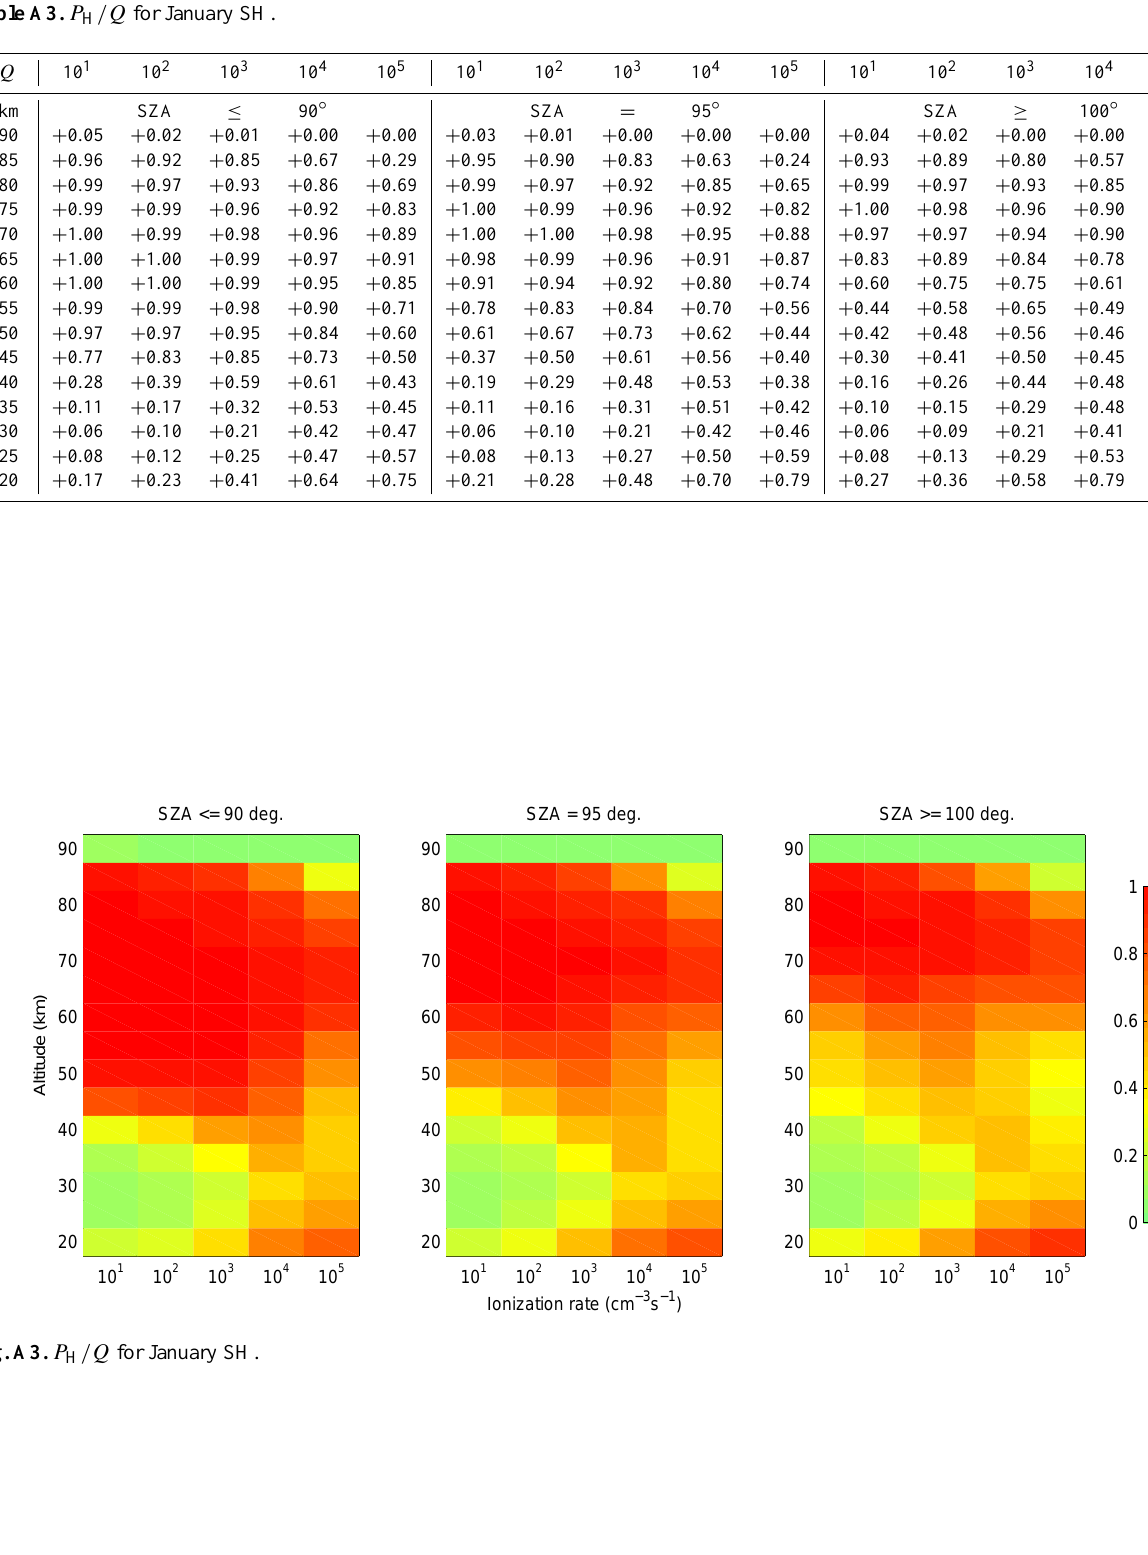
Table A3. P H /Q for January SH.